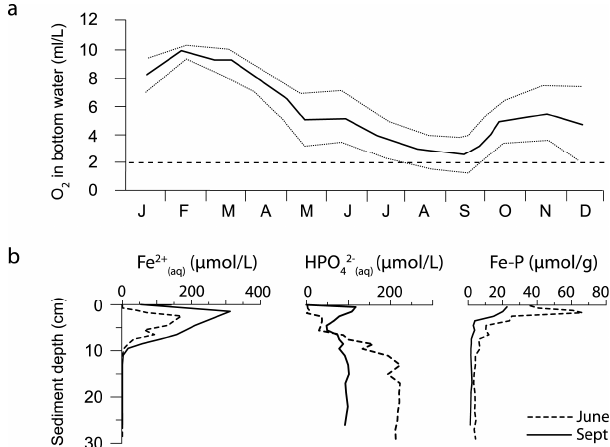
Fig. 4. (a) Seasonal variability in bottom water oxygen concentra- tion at site BY2 in the Arkona Basin. Solid line represents mean val- Figure 4. (a) Seasonal variability in bottom water oxygen concentration at site BY2 in 980 ues of 1995–2009, dotted lines the 20% and 80% quantiles. Data the Arkona Basin. Solid line represents mean values of 1995-2009, dotted lines the 981 from Baltic Sea Environmental Database at Stockholm University, and Swedish Meteorological and Hydrological Institute. (b) Pore- 20% and 80% quantiles. Data from Baltic Sea Environmental Database at Stockholm 982 water profiles of HPO − and Fe 2 + , and solid phase profile of Fe-P 4 at site BY2 in June and September sampling University, and Swedish Meteorological and Hydrological Institute. (b) Porewater 983